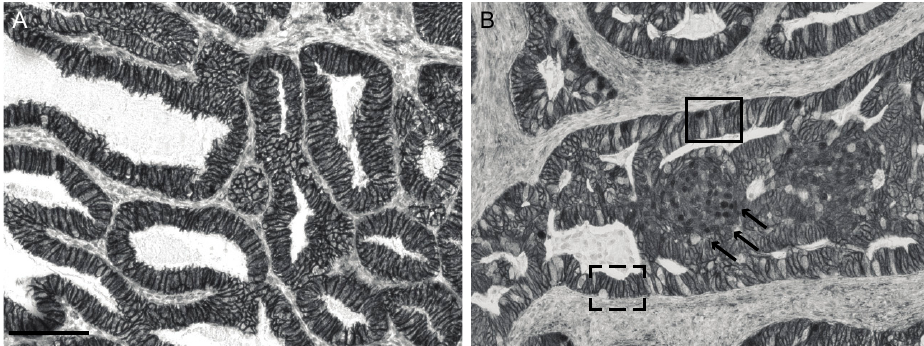
Figure 1. Steady-state distribution of beta-catenin in normal and cancer cell. ( A ) Membranous stain in endometrial cancer with normal distribution of beta-catenin. ( B ) Nuclear stain in endometrial cancer with aberrant beta-catenin (black box). Morule, a form of squamous metaplasia (black arrows). Normal membranous stain (black dashed box). Scale bar: 100 μ m.